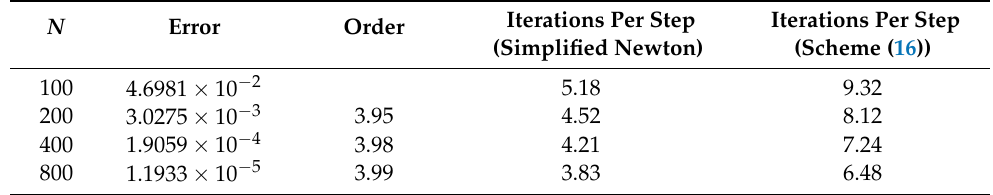
Convergence rate and mean number of approximated Newton iterations for the √ AMDMP4_TR2 method with α =